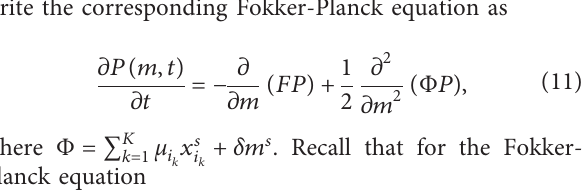
� 0 . 23 × 0 . 013 ) , ( c 23